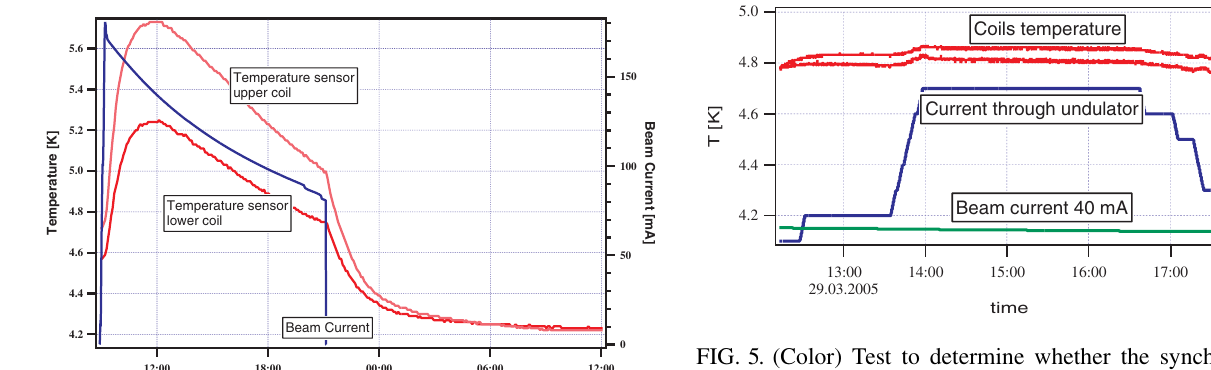
FIG. 5. (Color) Test to determine whether the synchrotron ra- diation produced by the undulator can heat cold surfaces. The gap is 16 mm, the current through the undulator is 40 mA (lower curve). The undulator current is changed between 0 and 600 A in several steps. From this curve it becomes clear that the heating of the undulator by self produced synchrotron radiation is small.